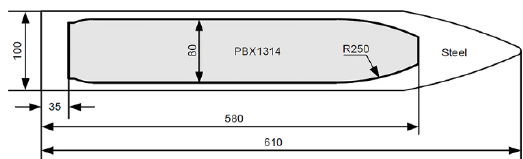
Figure 1. Geometries of the projectile and the inner PBX1314 main explosive. All the size parameters are in millimeters.